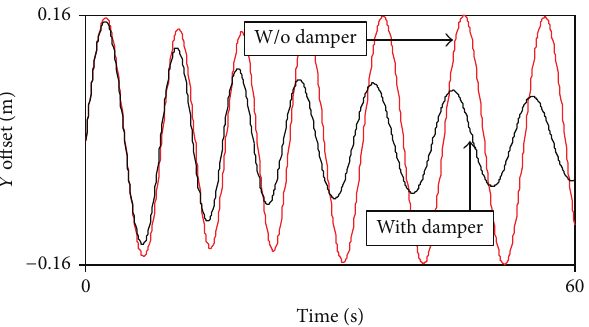
Figure 5: Spreader 𝑌 -offset in the case 𝑚 = 20 tons, 𝛾 = 0.1 .